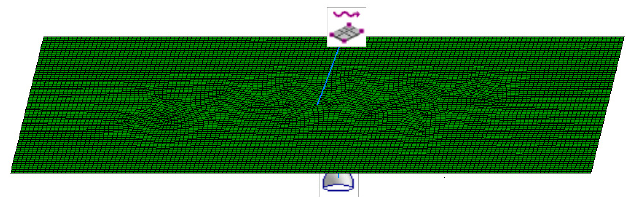
Figure 26. Compressible model of the random modal force and deterministic modal force.